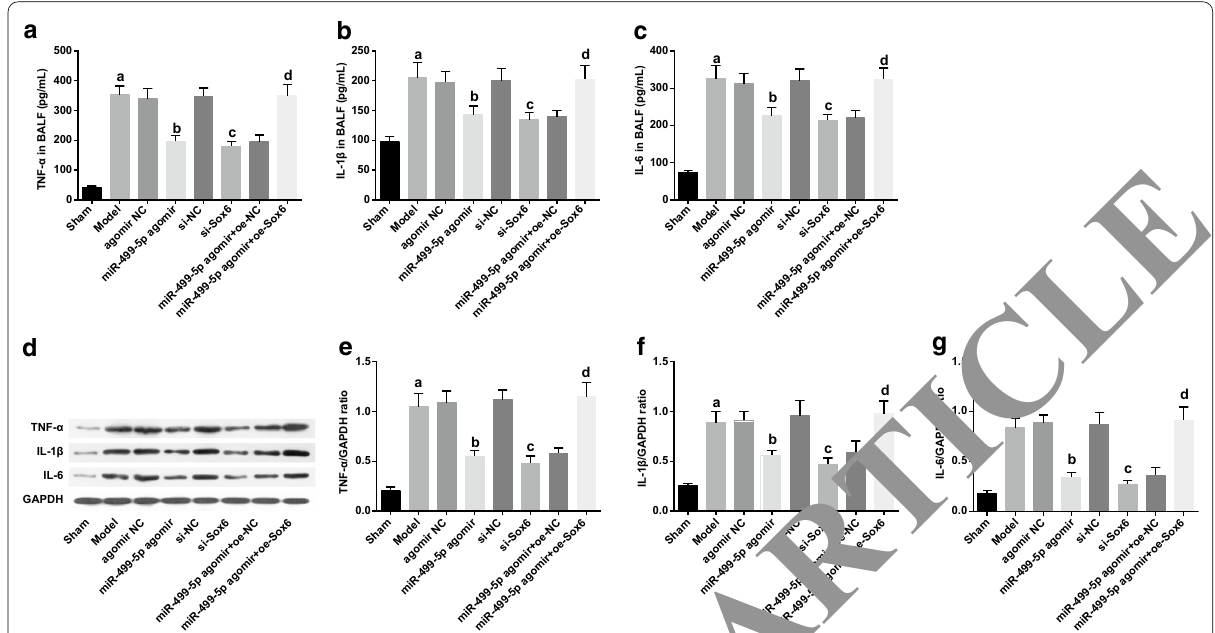
Fig. 4 Restored miR-499-5p or depleted Sox6 reduces TNF-α, IL-1β and IL-6 contents in BALF and lung tissues of sepsis-induced lung injury mice. a TNF-α content in BALF of mice in each group. b IL-1β content in BALF of mice in each group. c IL-6 content in BALF of mice in each group. d protein bands of TNF-α, IL-1β and IL-6 in lung tissues of mice in each group. e protein expression of TNF-α in lung tissues of mice in each group. f protein expression of IL-1β in lung tissues of mice in each group. G protein expression of IL-6 in lung tissues of mice in each group. (a) P < 0.05 versus the sham group. (b) P < 0.05 versus the agomir NC group. (c) P < 0.05 versus the si-NC group. (d) P < 0.05 versus the miR-499-5p agomir oe-NC group. + Measurement data were depicted as mean standard deviation, and data were assessed by one-way ANOVA followed by Tukey’s post hoc ±